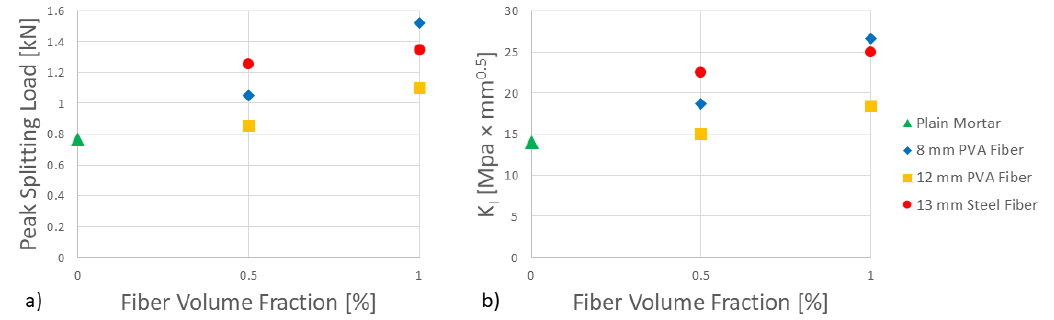
Figure 10. ( a ) Peak splitting load (SL) and ( b ) critical stress intensity factor (K I ) of substrate-repair interfaces for various fiber types and volume fractions .